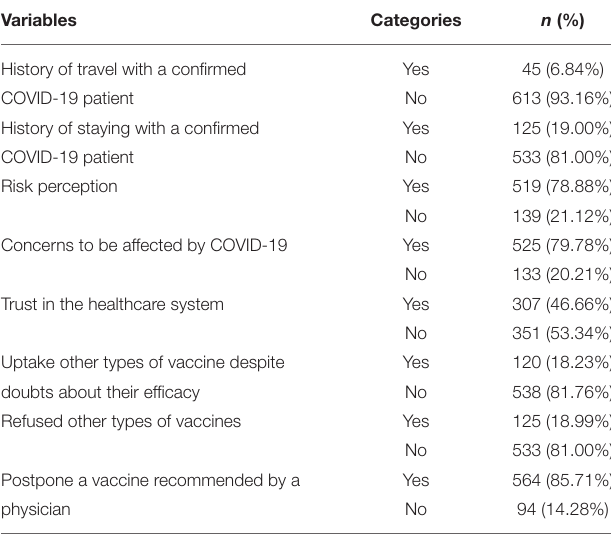
TABLE 2 | Contact history with COVID-19 patients, risk perception, and vaccination history of the study respondents ( N = 658). Variables